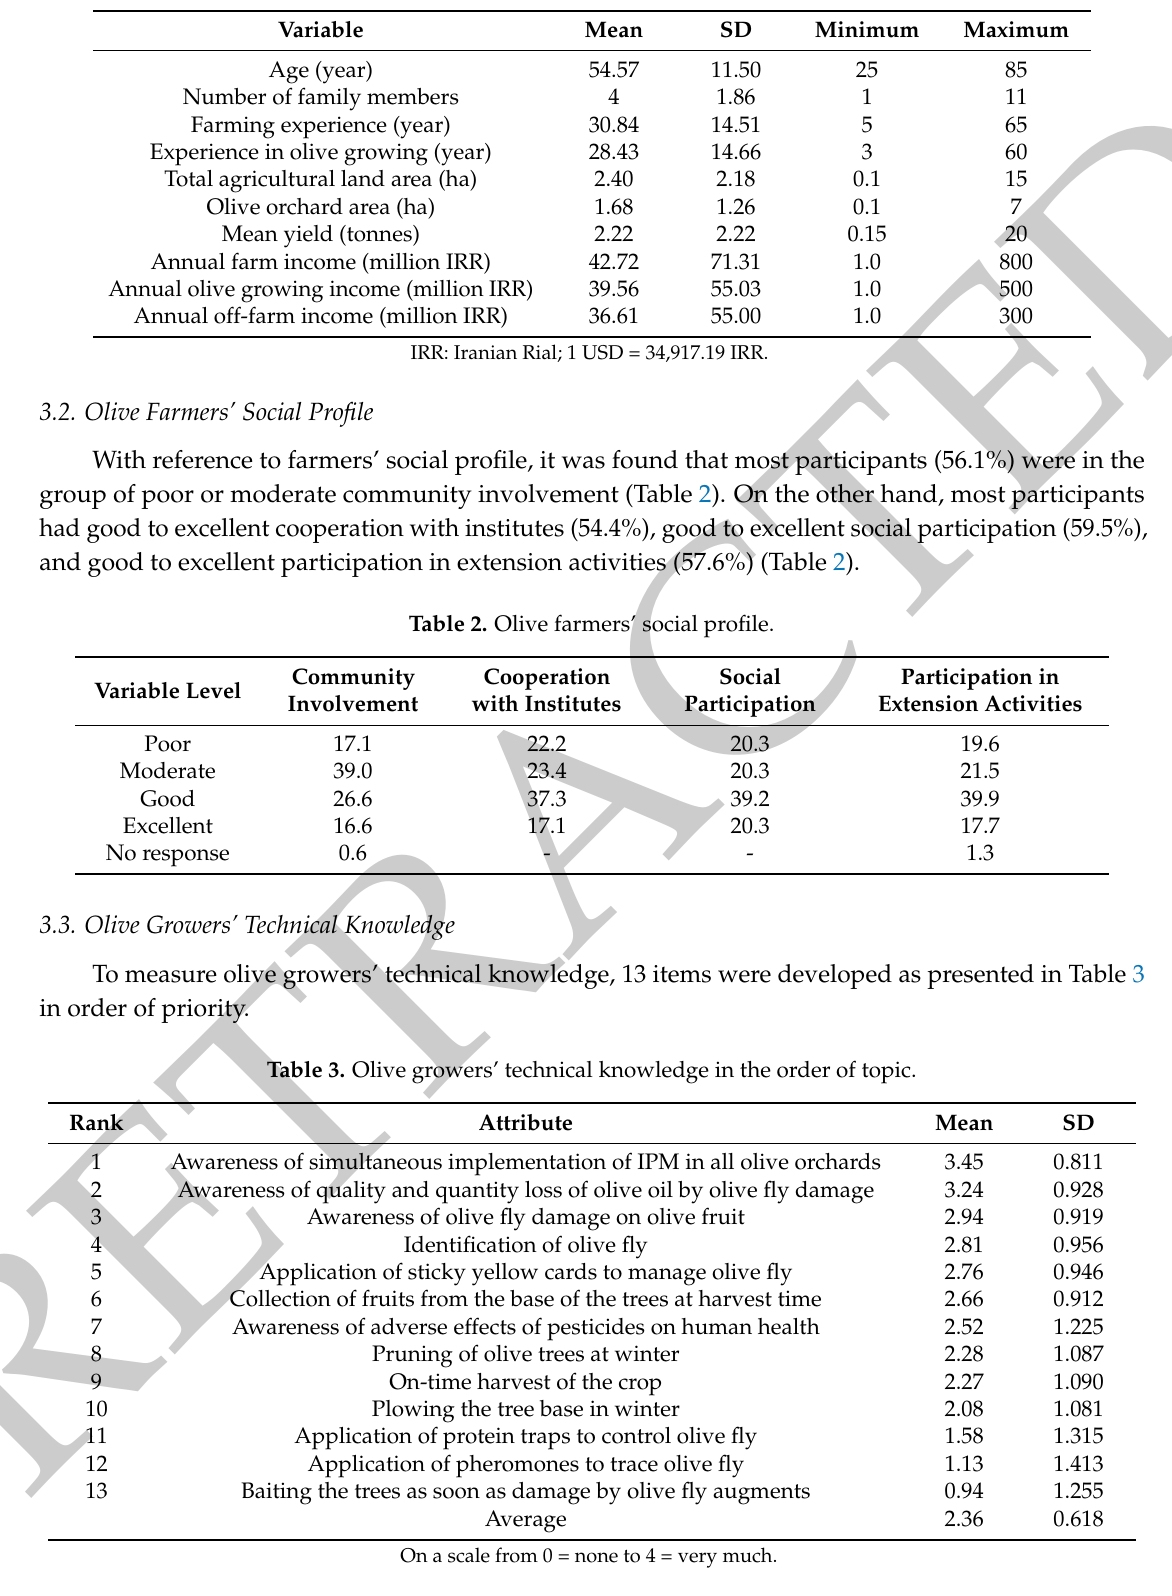
Table 1. Olive farmers’ demographic and economic profile.